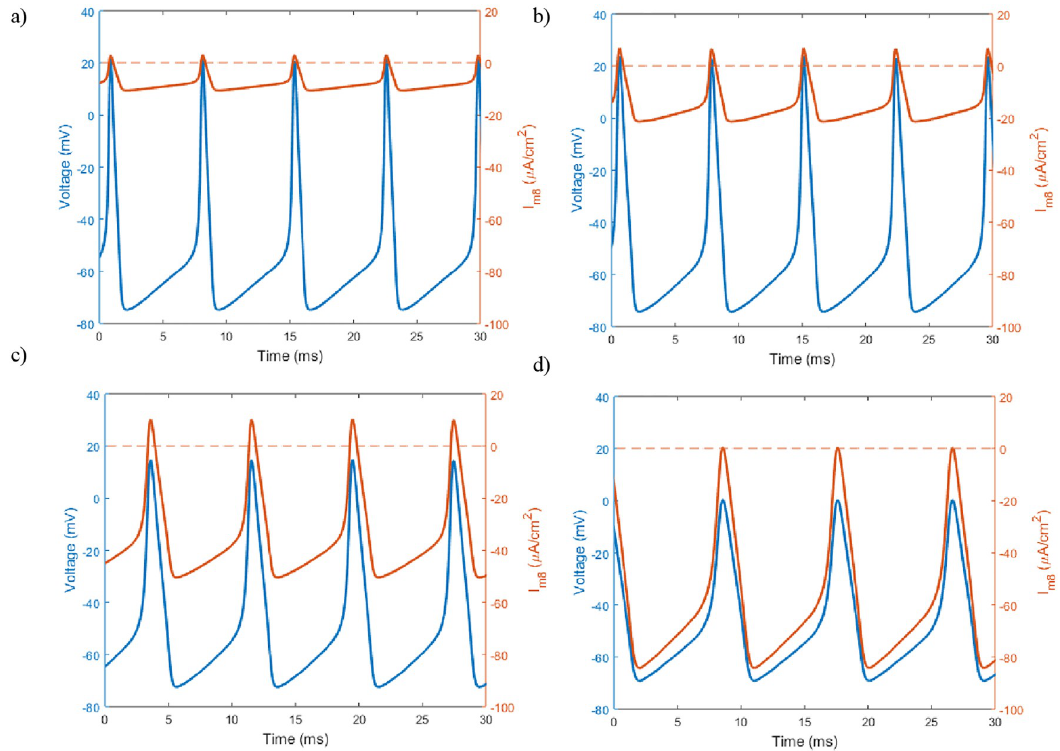
Fig 5. Sample traces of the neuron’s membrane potential and TRPM8 current in response to different static temperature levels. a-d) Temperature is set to 15˚, 12˚, 8˚ and 5˚ Celsius respectively. The membrane voltage is in blue with the TRPM8 current overlaid in red. The red dashed line denotes where the TRPM8 current switches from inward (negative values) to outward (positive values). Here g = 3 and all other parameter values are at set to Hodgkin-Huxley m 8